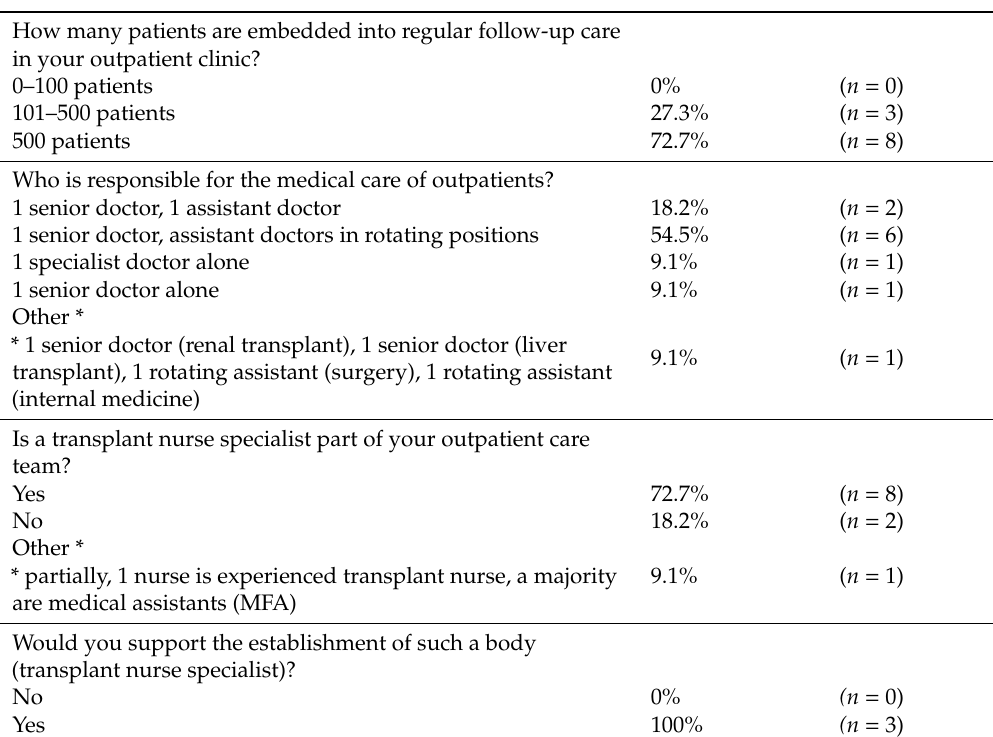
Table 2. Characterization of the outpatient center setting at liver transplant units in Germany ( n =